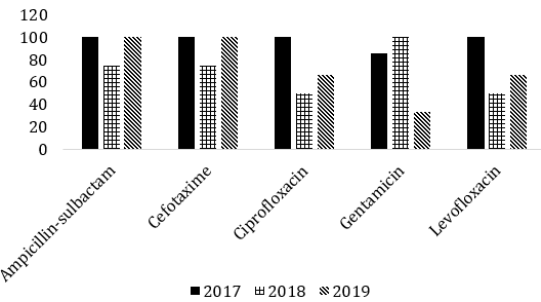
Figure 2. The pattern of antibiotic resistance in